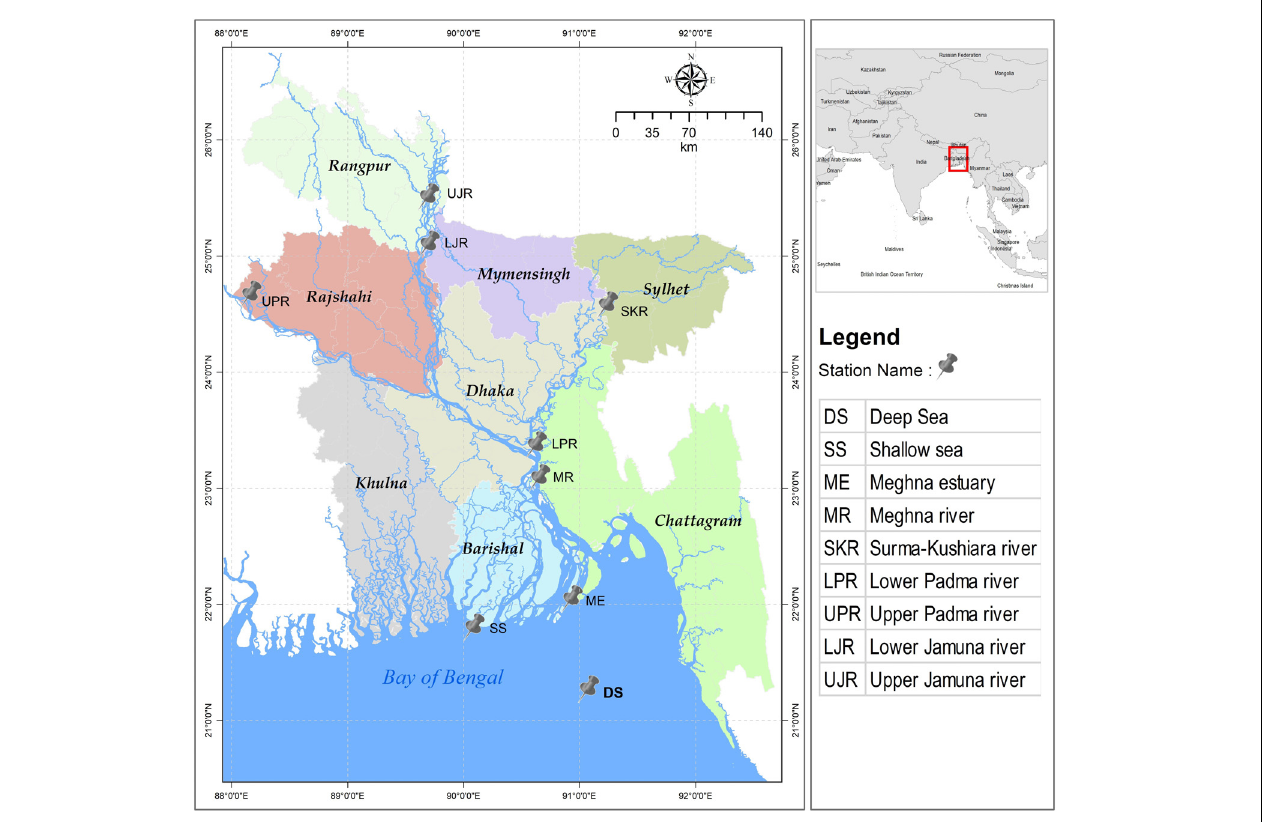
FIGURE 1 | Map indicating the nine sampling sites of five heterogenous habitats of the anadromous Hilsa shad Tenualosa ilisha in Bangladesh across its diverse migratory habitats, including the Bay of Bengal (SS and DS), the Meghna estuary (ME), the Meghna river and its upper tributary (MR and SKR), the Padma river (LPR and UPR) and the Jamuna river (LJR and UJR).